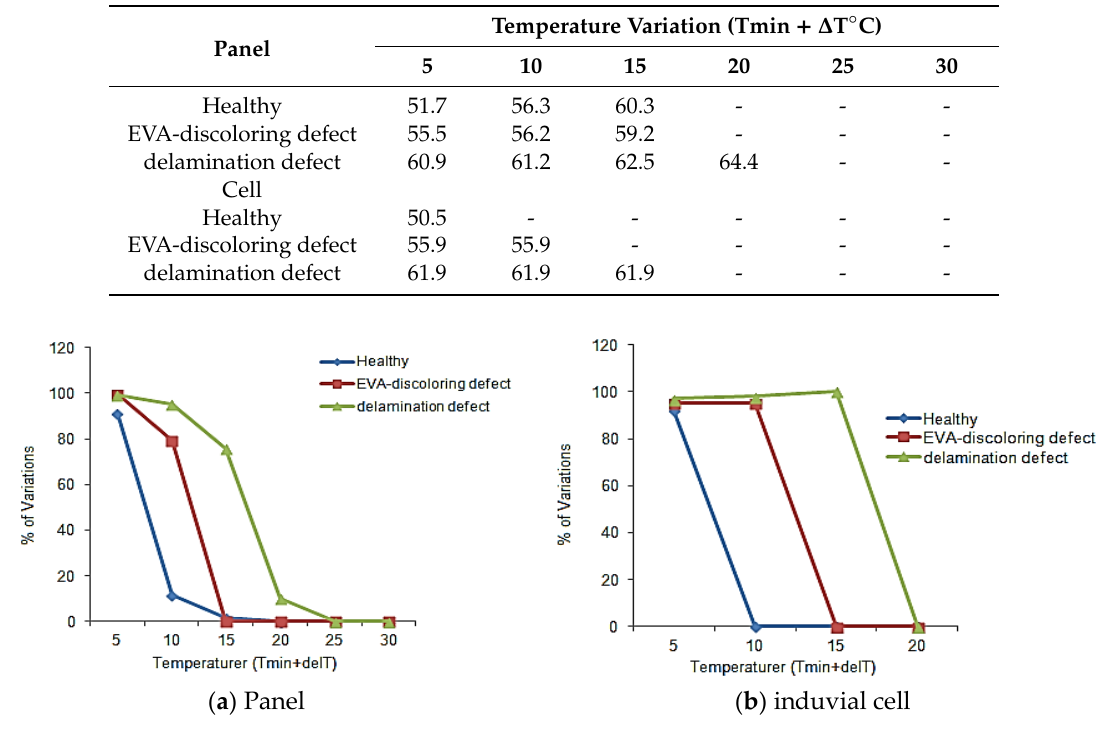
Figure 5. Percentage of thermal pixels variation of PV panel under different ∆T °C conditions.